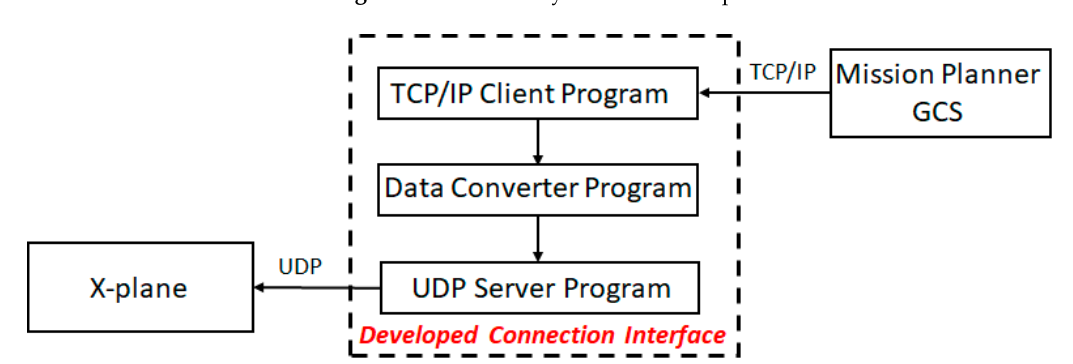
Figure 9. Outline of the developed connection interface.